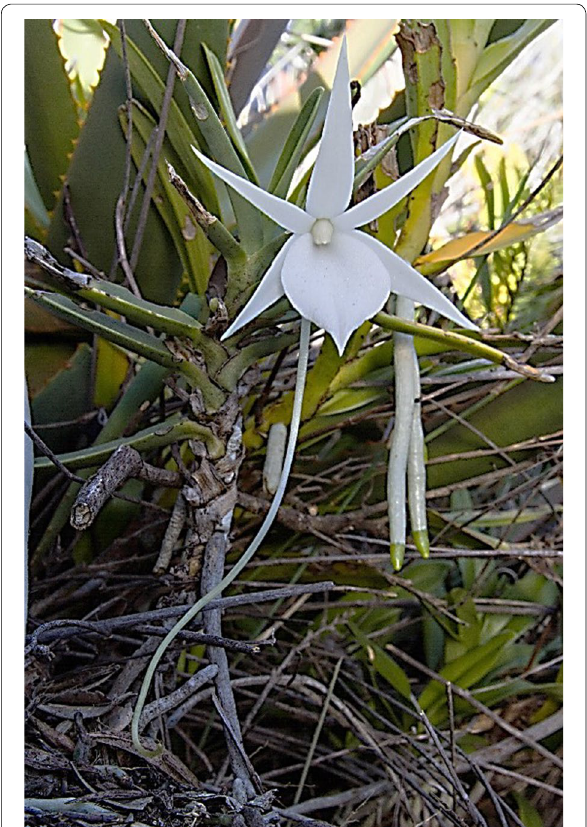
Fig. 1 (Left)— Angraecum protensum —one of several lithophytic orchids endemic to the Itremo Massif of the Central Highlands in Madagascar, shown in flower during the dry season (June 2012). The long nectar spur is visible to the lower left, and two young roots are seen on the lower right